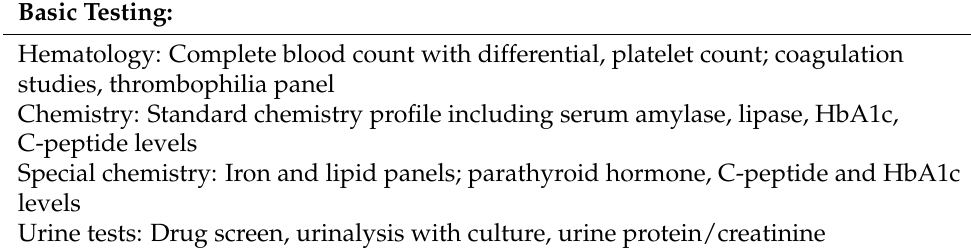
Table 2. Recipient